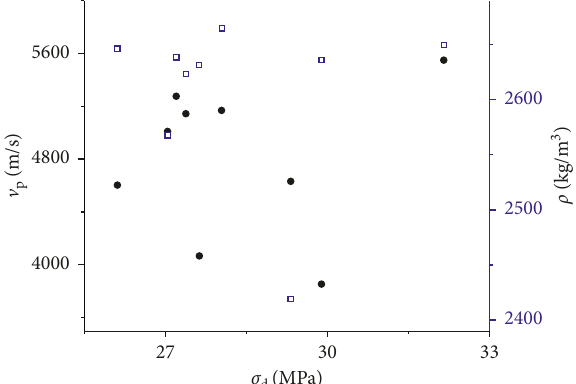
Figure 15: Relationship between dynamic tension strength, wave velocity, and density of rock